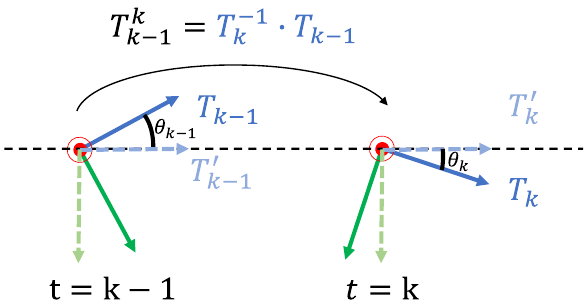
Figure 6. 2D side view of the camera reference system in two adjacent frames. T (cid:48) the ideal camera reference system when the vehicle is stopped. T k − 1 and T k are the actual camera · T = T − 1 poses. T k k − 1 is the ego-motion between two frames. The black dashed line is the ideal k − 1 k horizontal line parallel to the ground plane. θ k − 1 and θ k are the pitch angles relative to the ground plane. The actual camera extrinsics to the ground plane are T k − 1 · T (cid:48) to the ground plane normal vector. Best view in